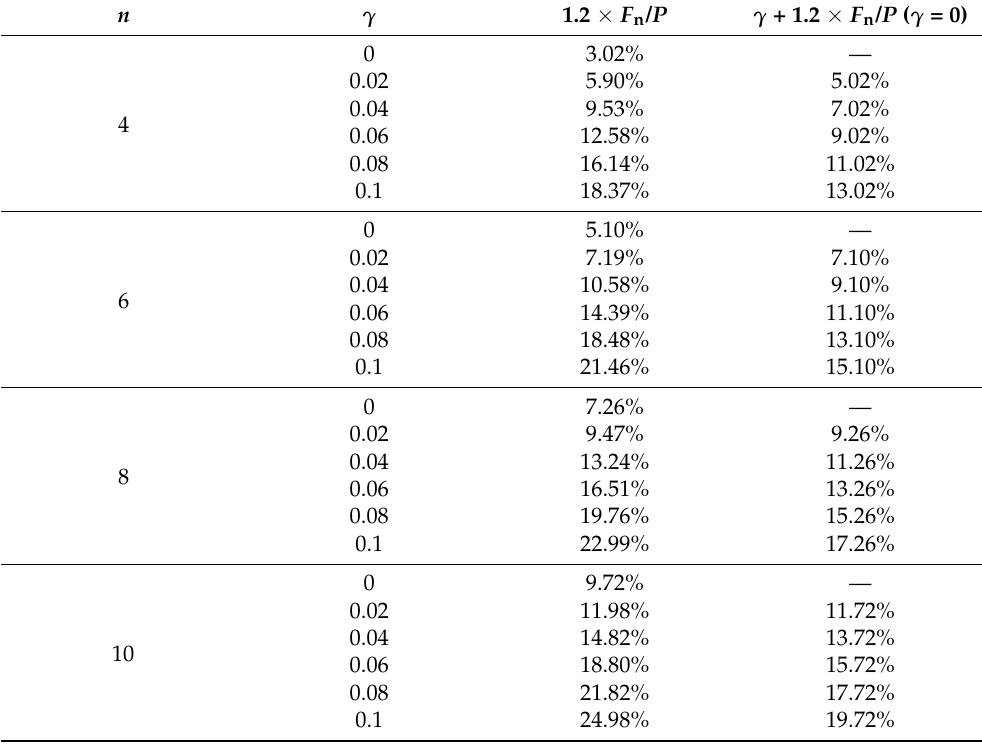
Table 6. Comparison of 1.2 × F n / P under horizontal and vertical loads with that under only vertical